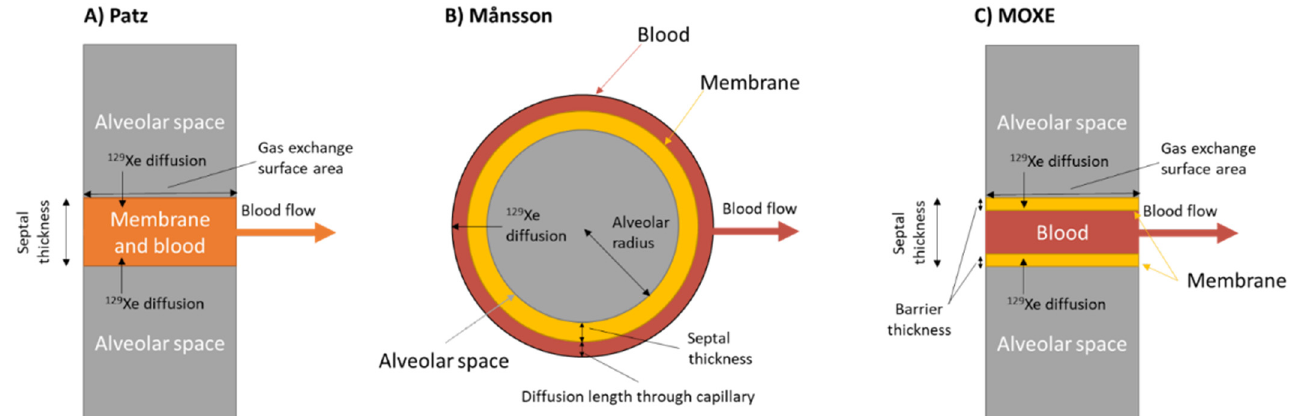
Figure 21. Different 1D analytical models of diffusion in the lung. ( A ) Shows the Patz model wherein xenon diffusion is modeled to diffuse from alveolar space into a combined membrane and blood compartment [76,77]. ( B ) Shows the Månsson that models the alveolus as a symmetrical sphere but considers the membrane and blood compartments separately [78]. ( C ) Shows the MOXE model that considers the same geometry as the Patz model but solves for both the membrane and blood signal